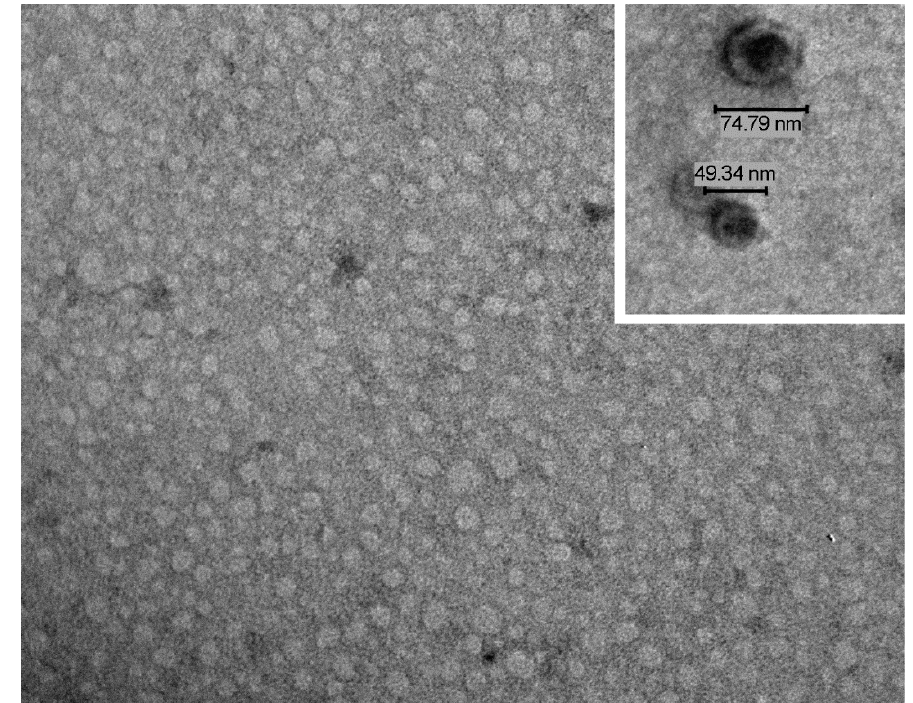
Figure 1. Salivary EVs characterization. A representative transmission electron microscopy image of EVs isolated by a charge-based precipitation method, showing a carpet of vesicles in the nano-range. In the inset, the bars indicate the size of the extracellular vesicles (EVs). The preparation was stained with NanoVan (JEOL Jem-1010 electron microscope, original magnification × 75,000; inset × 150,000). By comparing the miRNA expression of cancer patients and matched controls, we observed an up-regulation of miR-412-3p, miR-512-3p, miR-27a-3p and miR-494-3p in patients with oral squamous cell carcinoma. MiR-512-3p and miR-412-3p were also potentially sensitive and specific biomarkers, as indicated by the high AUC values (0.847 and 0.871 respectively, with p values < 0.02) and a maximum Youden’s Index. Interestingly, we also observed an exclusive expression of miR-302b-3p and whether the tumor-enriched miRNAs could be functionally related to the tumor. We observed